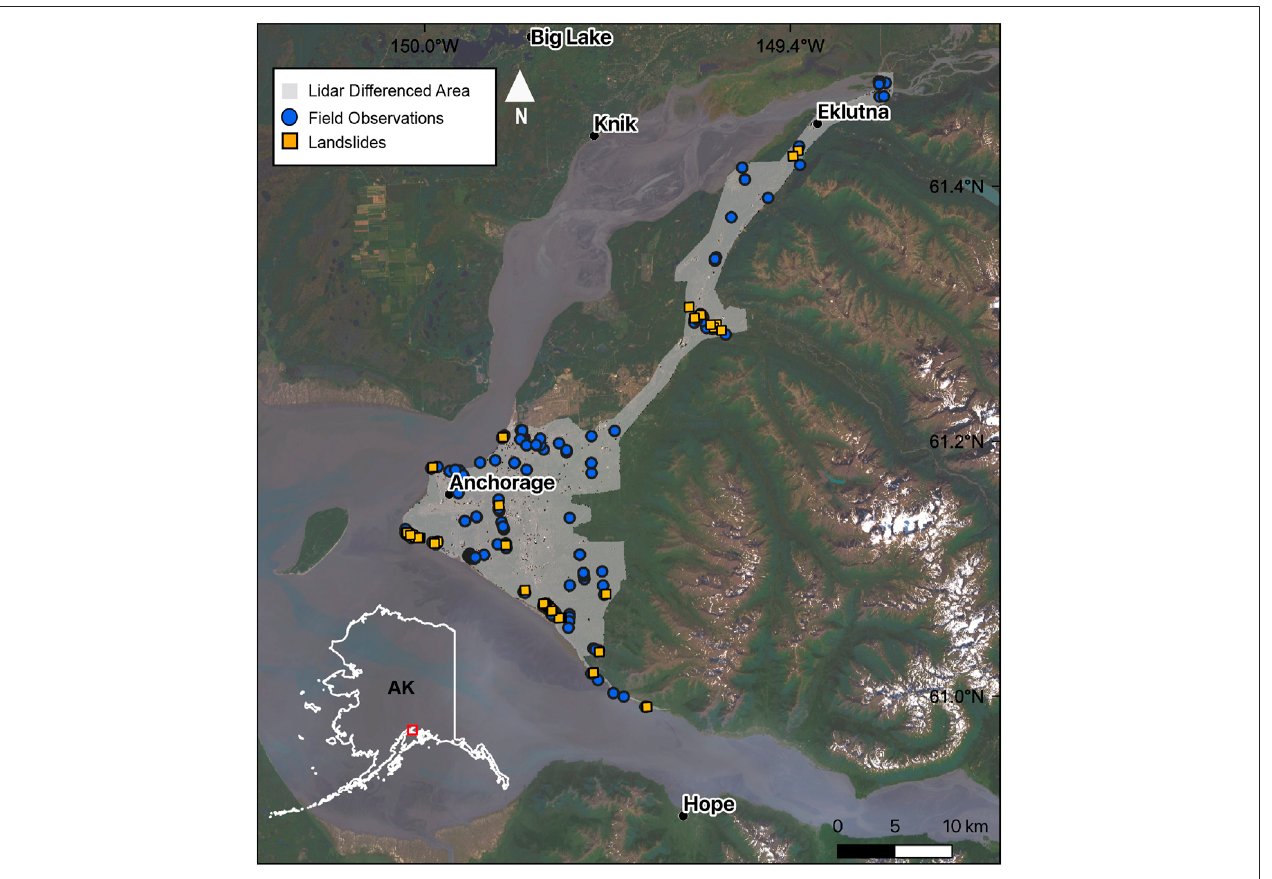
FIGURE 1 | Location of the study area within Anchorage, AK. The extent of the lidar differenced area is shown in gray. Landslides are shown as orange squares whereas he approximate location of fi eld observations are shown as blue circles. The fi eld observations consist of multiple photos of all types of ground failure (including ground failureas a result ofliquefaction) taken from various vantage points (ground, helicopter). Orange squares are locations that are included in the landslide inventory for this study, which also have corresponding fi eld observations in most